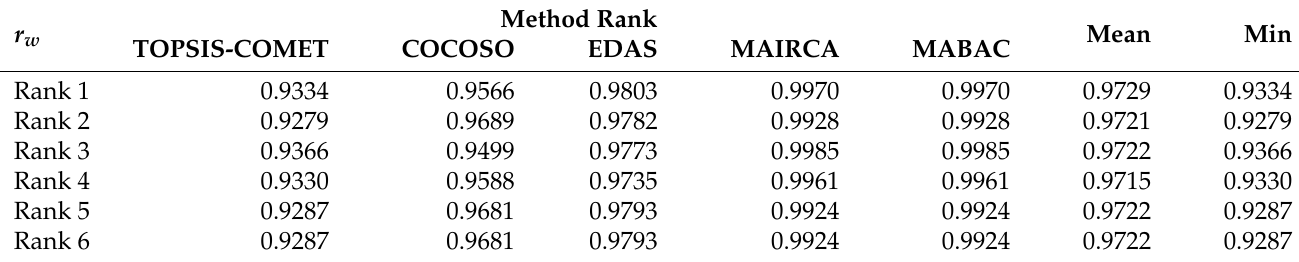
Tables 8 and 9 display the values of the correlation coefficients between the candidate compromise rankings and the particular MCDM method rankings. The best match to the rankings expressed by r w , provided by the methods used in the study, was obtained for Rank 3 after eliminating the COCOSO ranking. Therefore, this candidate’s rounded mean and minimum match values are 0.97 and 0.94, respectively. Table 8. Values of similarity coefficient r w for compromise ranking candidates with consideration of sample smartphones.